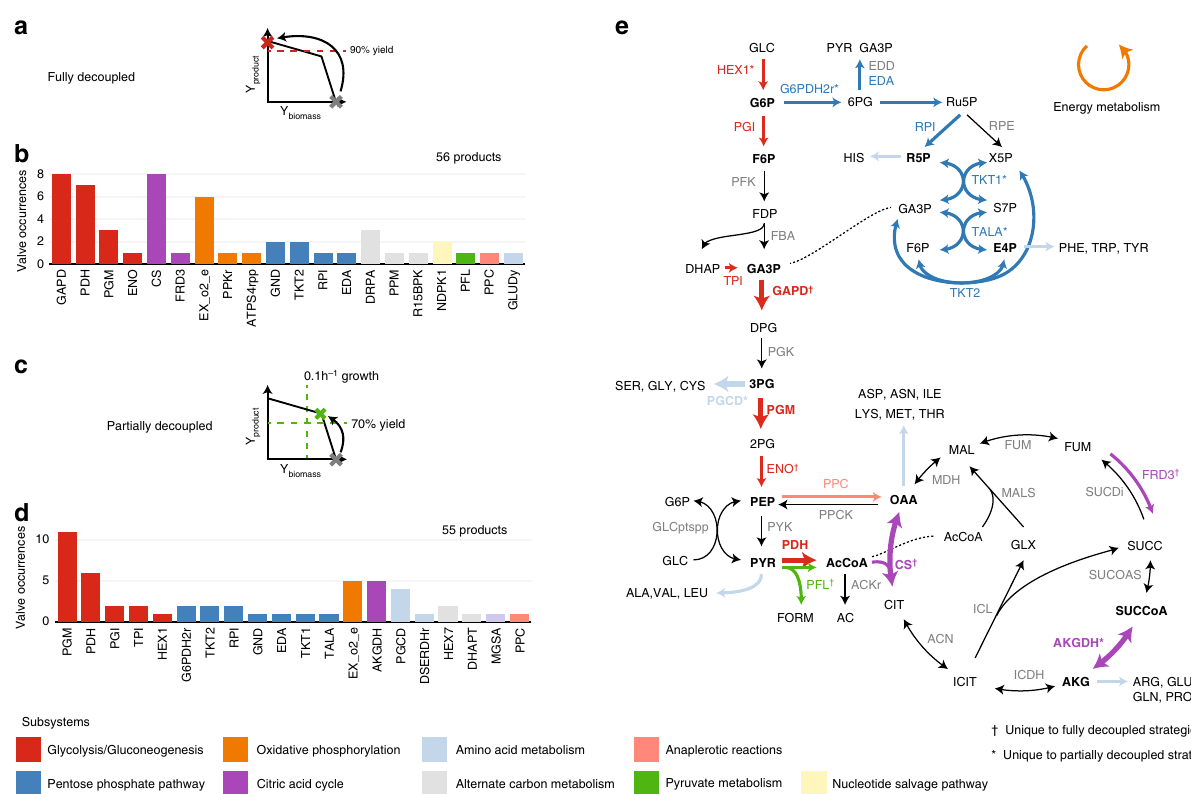
Fig. 4 Valve occurrences in intervention strategies, categorized by metabolic subsystem. a Fully decoupled strategies target over 90% theoretical maximum production without cell growth in the second (production) state. b Single valves identi fi ed for fully decoupled strategies, single valves can independently redirect fl ux. c Partially decoupled strategies achieve over 70% theoretical yield while maintaining a biomass yield of 0.01 gdw mmol − 1 . d Single valves identi fi ed for partially decoupled strategies. e Central metabolic map highlighting identi fi ed valves and associated subsystems. Bolded reactions refer to the top fi ve valves for each decoupling strategy. Bolded metabolites refer to metabolites at the center of the bow-tie architecture